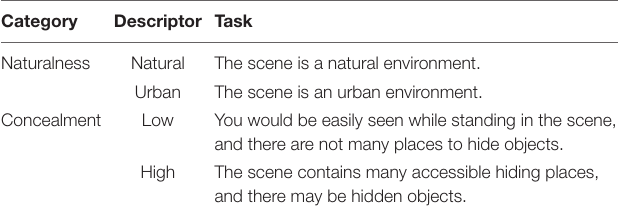
TABLE 2 | Descriptor of the categorization tasks and the instructions as presented to